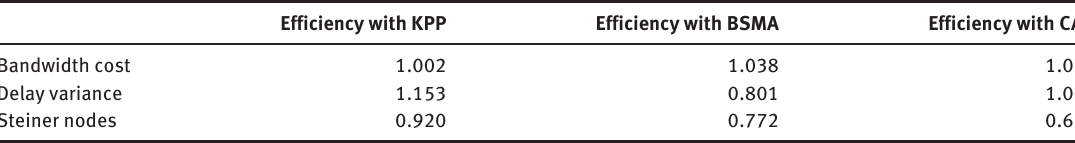
Table 4. Efficiency of the Proposed Method.